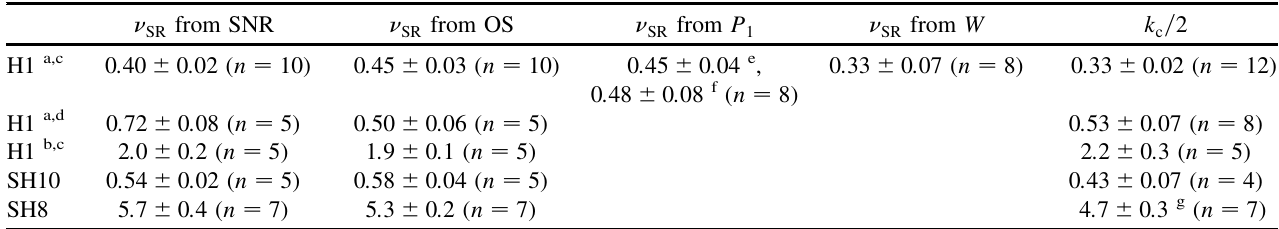
TABLE I. Comparison between (cid:2) SR (Hz) and k c ( s (cid:1) 1 ). Resonance frequency, (cid:2) SR , obtained from SNR, OS, P 1 , and W vs hopping rate, k c , at the coexistence force (see Sec. I in Ref. [18] for k c ). (cid:2) SR was chosen as the peak value of each SR quantifier for each molecule. n ¼ the number of molecules analyzed. (cid:2) SR from SNR